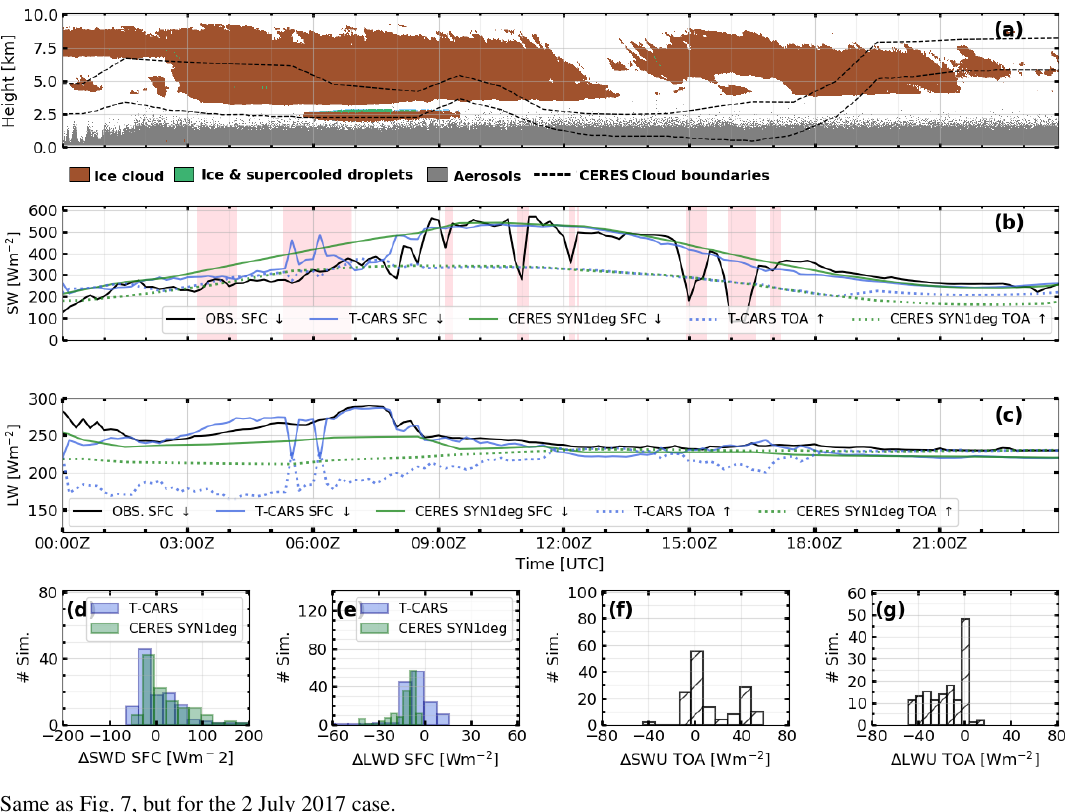
Figure 8. Same as Fig. 7, but for the 2 July 2017 case.